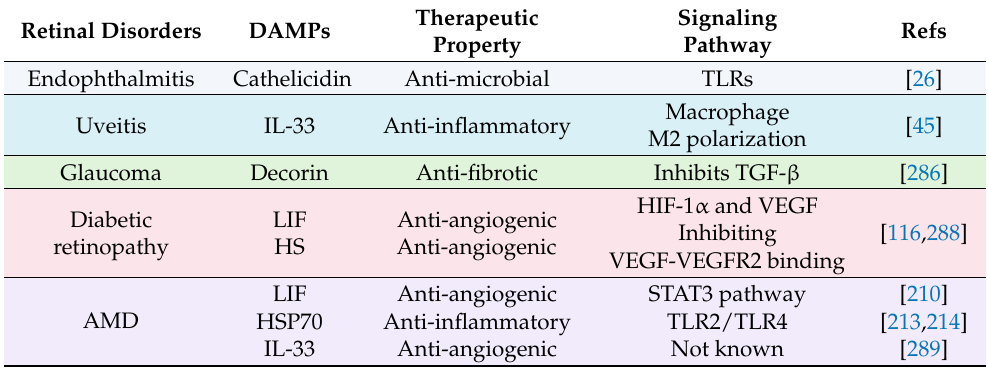
Table 12. DAMPs as therapeutic agents. Retinal Disorders DAMPs